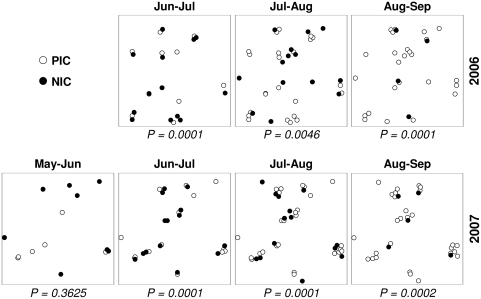
Spatial distribution of newly-infected corals (NICs; full circles) in relation to previously-infected corals (PICs; empty circles) within the studied site.The p-value for each pair of sequential sampling dates is associated with the mean minimum nearest neighbor statistic,  (Eq. 3). The null hypothesis is that the average  for a given pair is not significantly different from that expected had the infection transmitted randomly within the susceptible corals with equal probability for all corals. p-values smaller than 0.025 show that there is a significant deviation from random infection and, in such cases, NICs are found to develop in significant proximity to PICs.